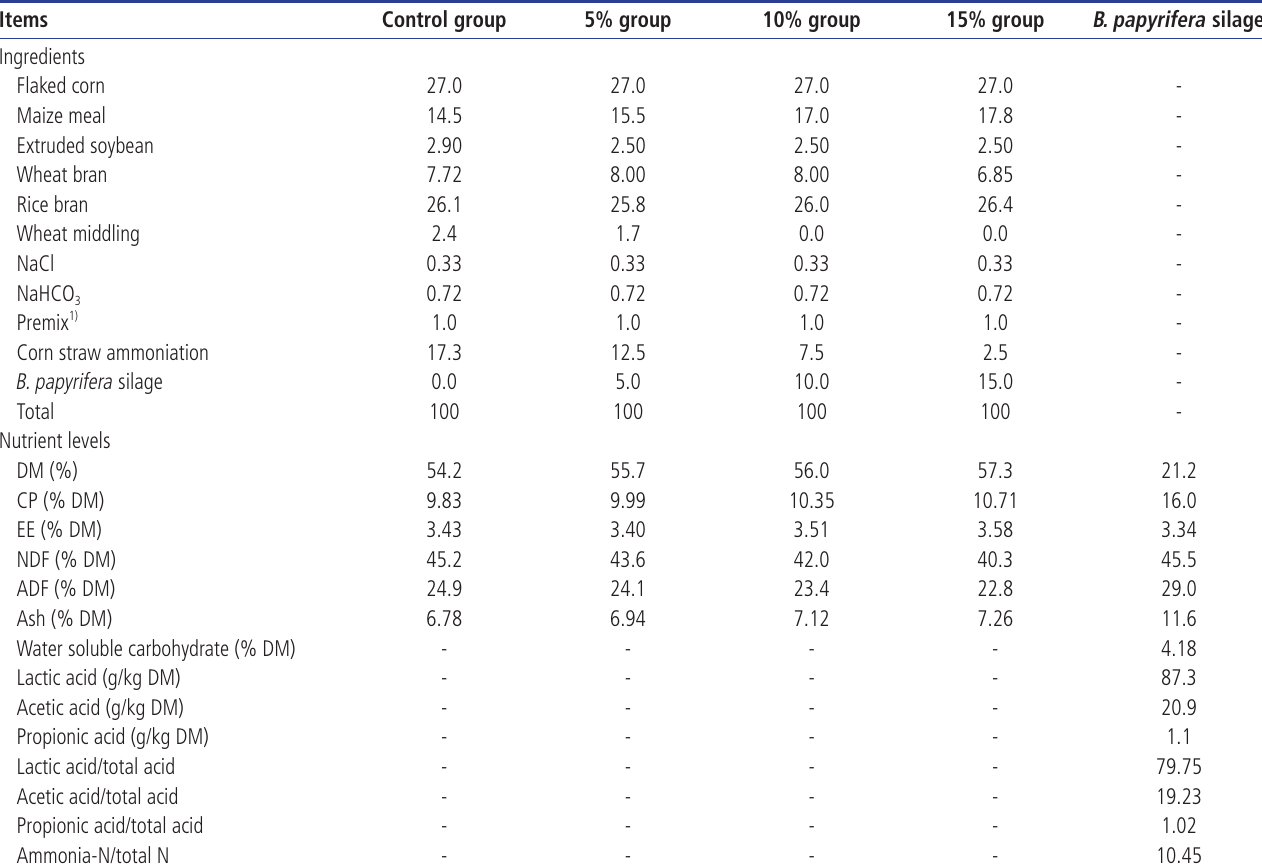
Table 1. Ingredients and nutrition levels of diets (air dry basis, %) Items